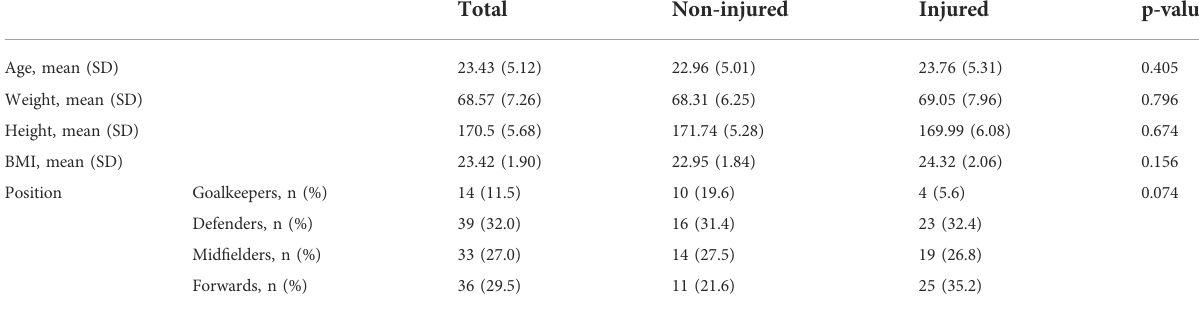
TABLE 1 Professional soccer players ’ demographic